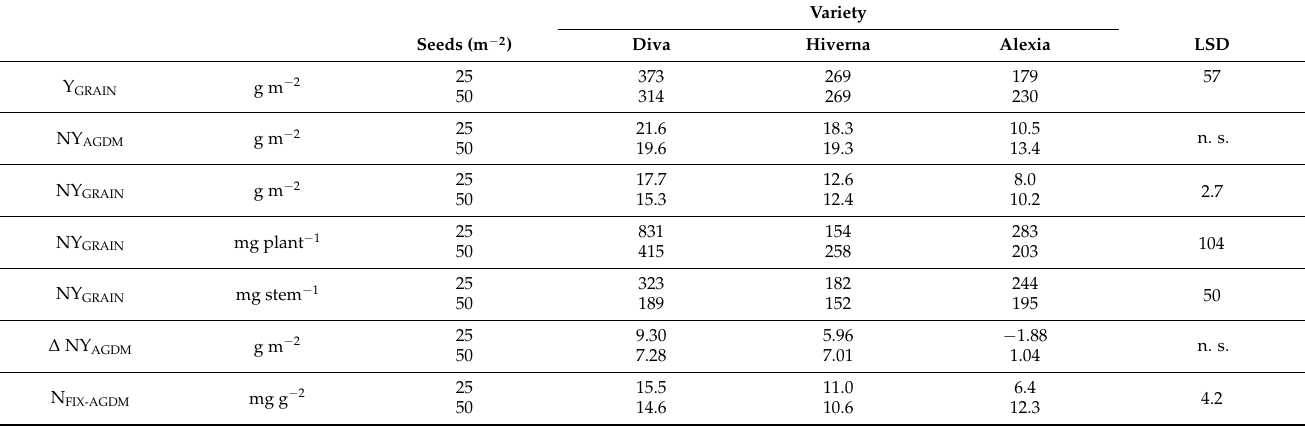
Table 3. Yield and nitrogen parameters of faba bean as affected by variety × seeding